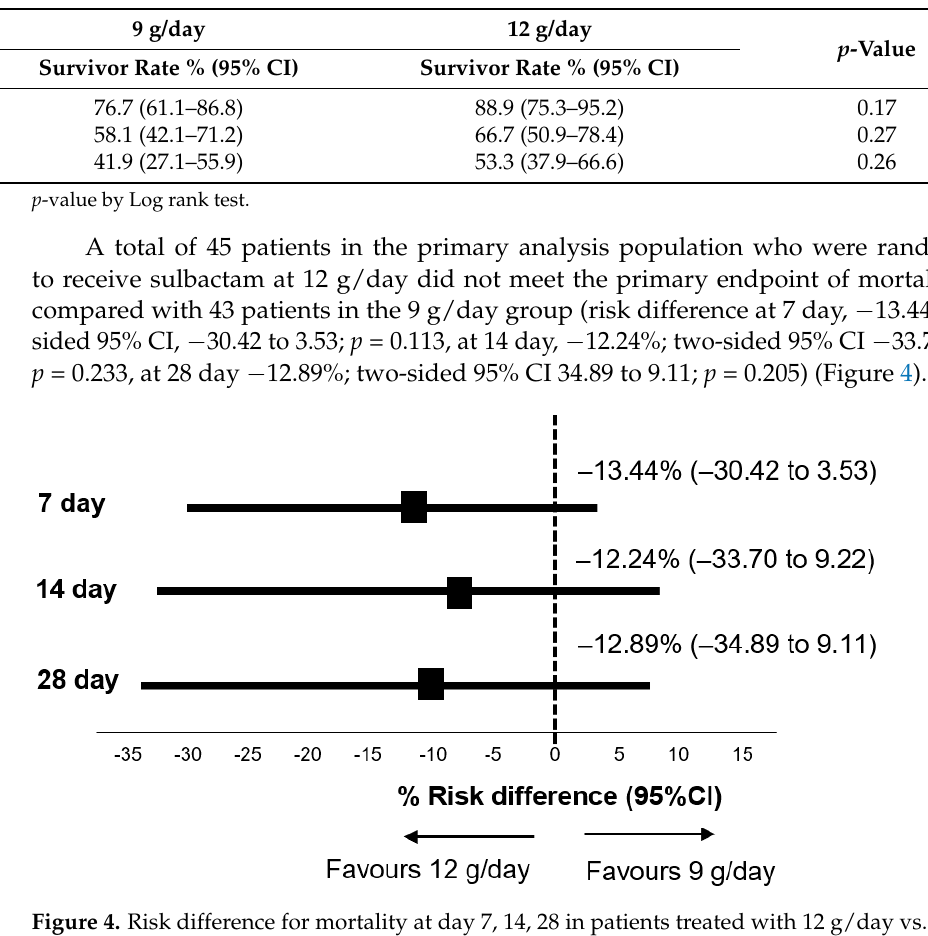
Figure 3. Kaplan–Meier survival curves for 28-day mortality of XDRAB pneumonia patients in re- lation to the administered dose of sulbactam . Table 2. Seven, 14, 28 days survival of XDRAB pneumonia patients in relation to the administered dose of sulbactam.